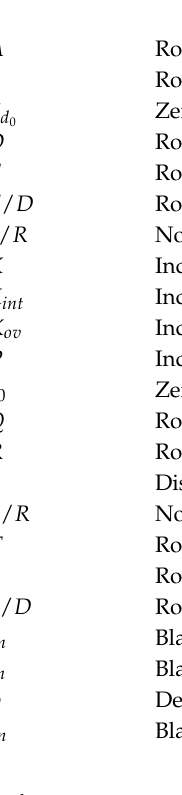
Table S1: T-Motor 16 inch × 5.4 inch Airfoil